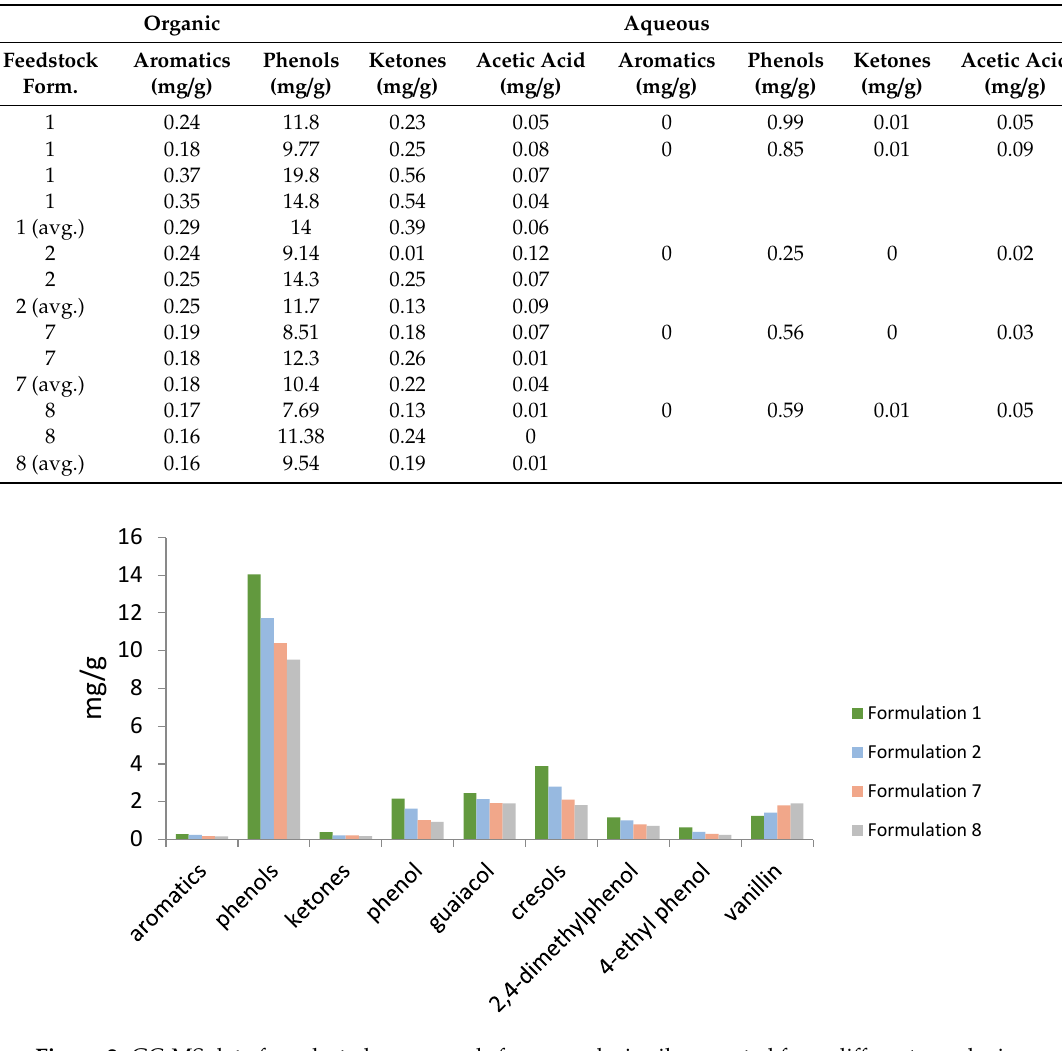
Figure 2. GC-MS data for selected compounds from pyrolysis oil generated from different pyrolyzing.